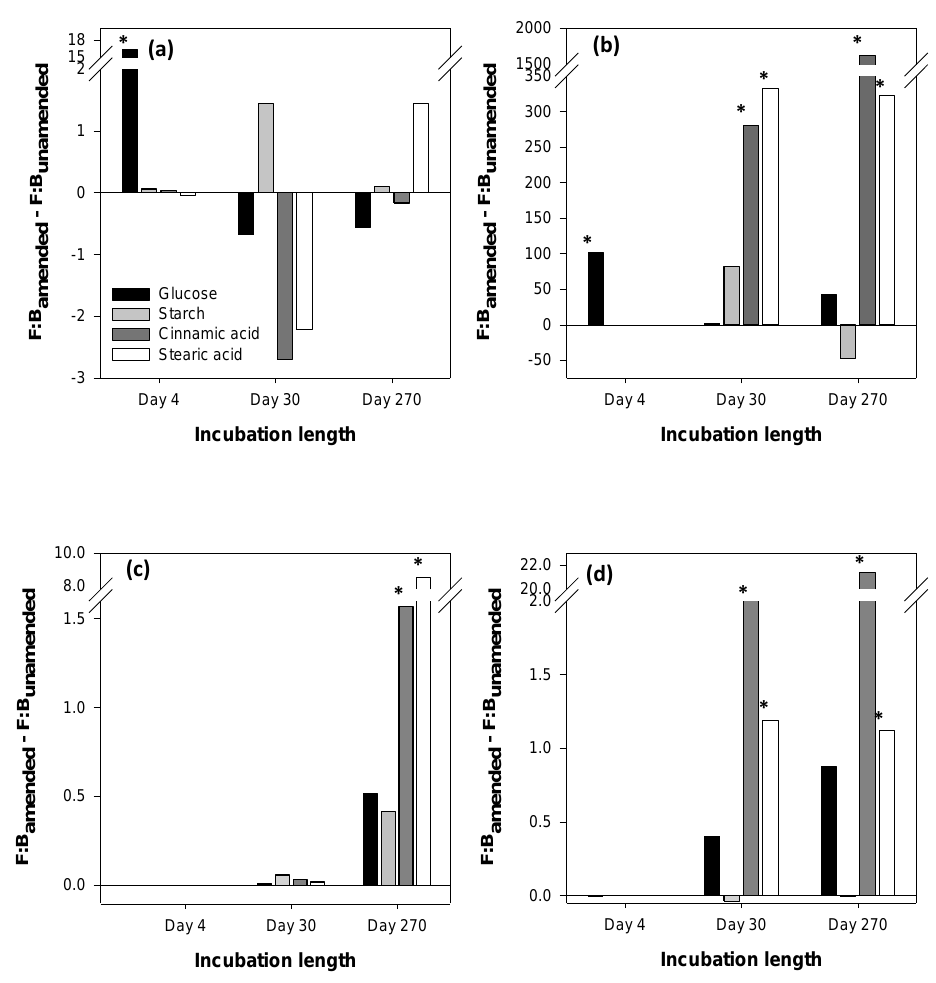
Figure 3. The difference in the fungal-to-bacterial gene copy ratios between amended and unamended treatments (F:B amended - F:B unamened ) in response to the addition of four substrates in Mollisol (a) , Ultisol (b) , Andisol (c) , and Gelisol (d) . ∗ indicates that F:B amended -F:B unamended is significantly different from